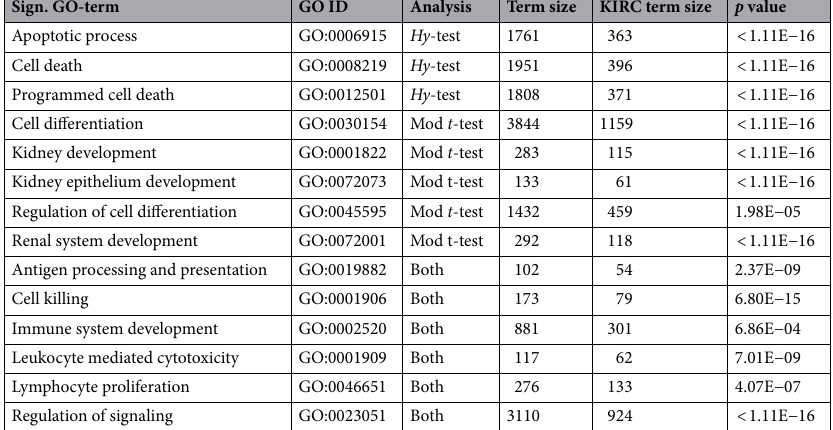
Table 2. GO-terms significantly associated with “kidney cancer” among significant GO-terms found using Hy-test, t -test and both procedures. Term size is the number of genes that compose a GO-term; KIRC term size is the number of GO-term genes associated with kidney cancer; p -value is computed by using the hypergeometric distribution.